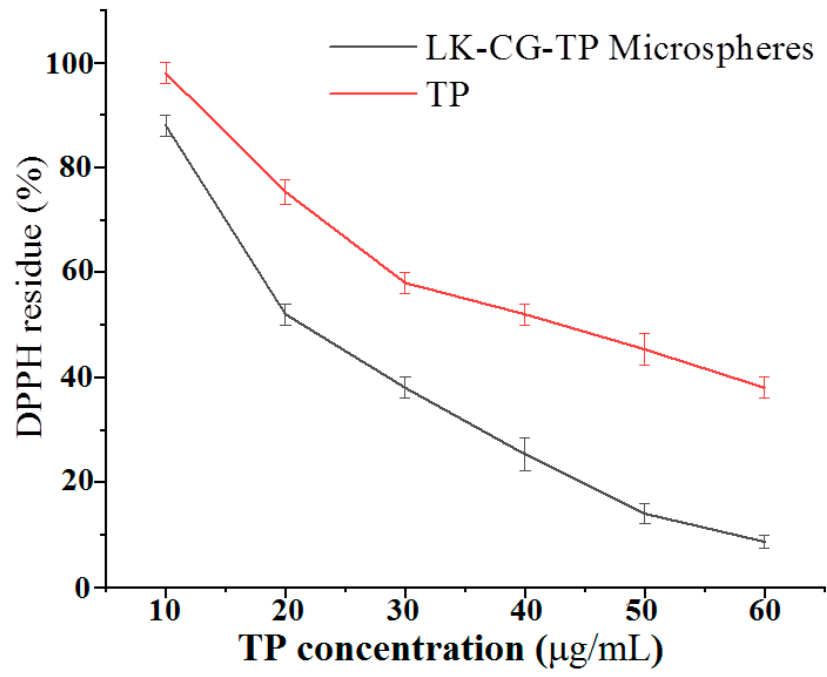
Figure 7. DPPH scavenging rate by concentration of TP and LK_CG_TP